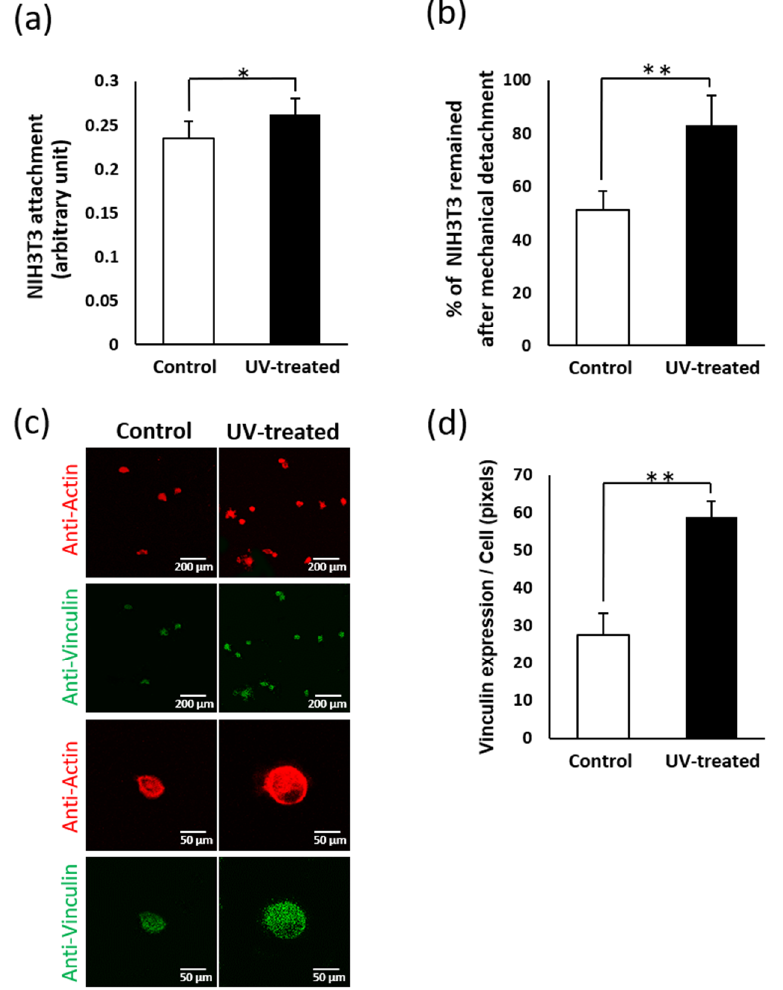
Figure 7. ( a ) Total number of attached NIH3T3 cells cultured for 24 h on titanium disks with and without UV treatment. Data are mean ± SD ( n = 6). * p < 0.05, statistically significant difference between the control and UV-treated surfaces. ( b ) Percentage of attached NIH3T3 cells remaining after mechanical detachment; cells were cultured for 24 h on titanium disks with and without UV treatment. Data are mean ± SD ( n = 6). ** p < 0.01, statistically significant difference between the control and UV-treated surfaces. ( c ) Cytoskeletal arrangement and expression of focal adhesion protein vinculin in NIH3T3 cells that remained on the titanium surface after mechanical detachment. Representative confocal microscopic images of cells stained with rhodamine phalloidin for actin filaments (red) and anti-vinculin (green). Cells cultured on titanium disks with and without UV treatment for 24 h were used. ( d ) Image-analysis-based vinculin expression. Data are mean ± SD ( n =